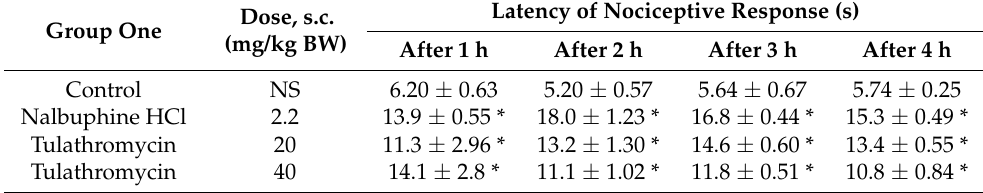
Table 1. Effects of tulathromycin (20 and 40 mg/kg BW, s.c.) and nalbuphine hydrochloride (2.2 mg/kg BW, SC) on the latency of nociceptive response induced in the hot-plate test in mice (mean ± SD; n =